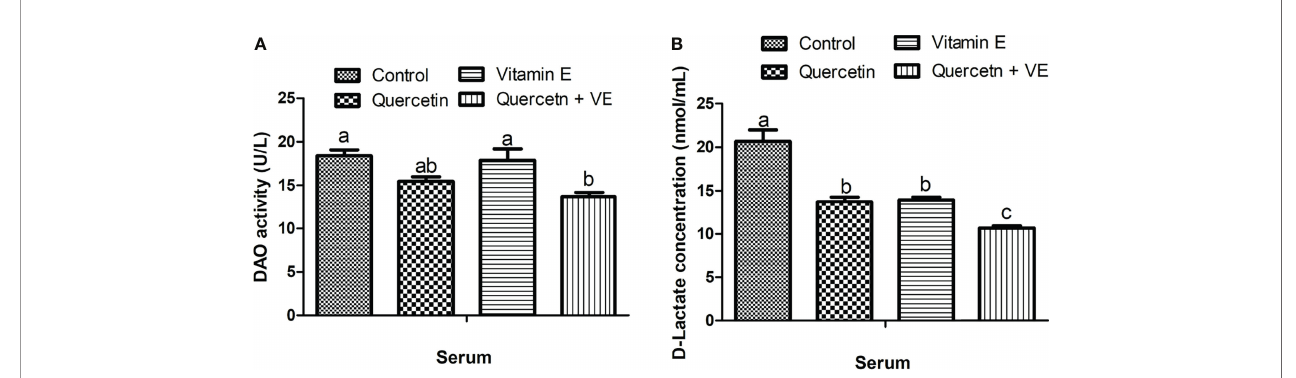
FIGURE 2 | Effects of quercetin (Q), vitamin E (VE), and Q + VE on the activities of serum diamine oxidase (DAO) and D-lactate (D-LA) (intestinal biomarkers) after 14 weeks experimental feeding. Bars without the same letter differed signi fi cantly (P < 0.05). (A) serum DAO; (B) D-LA.